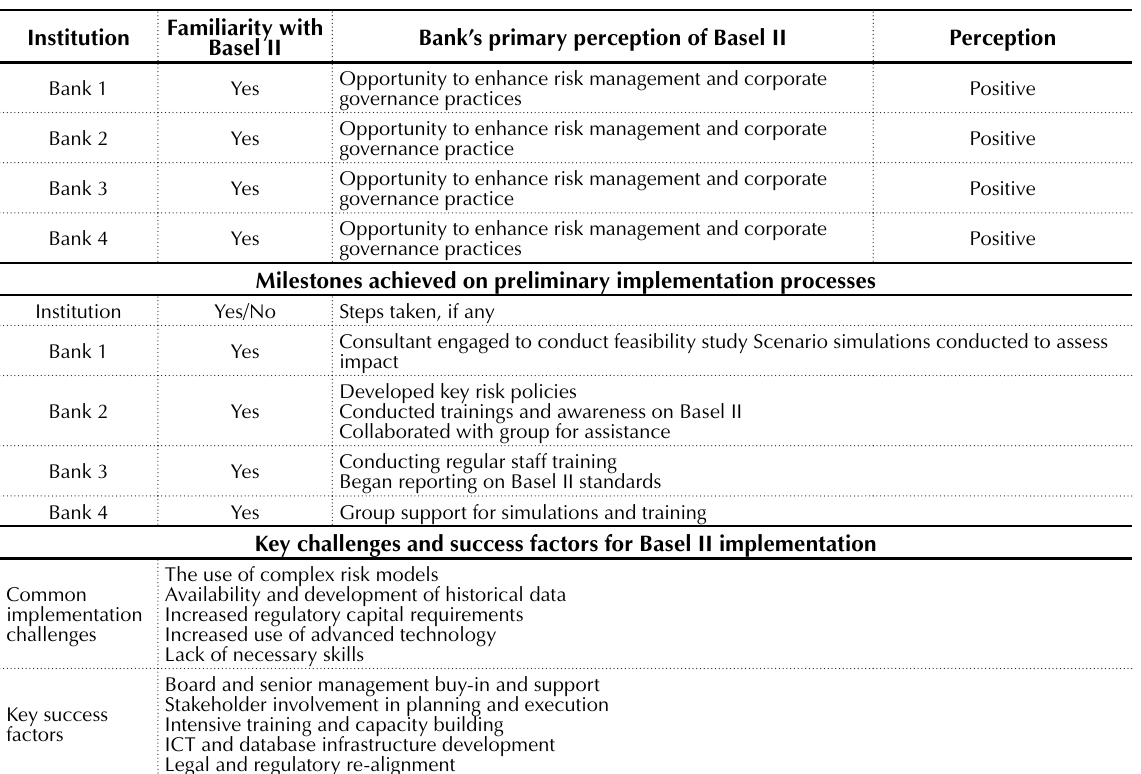
Table 2. Institutional awareness